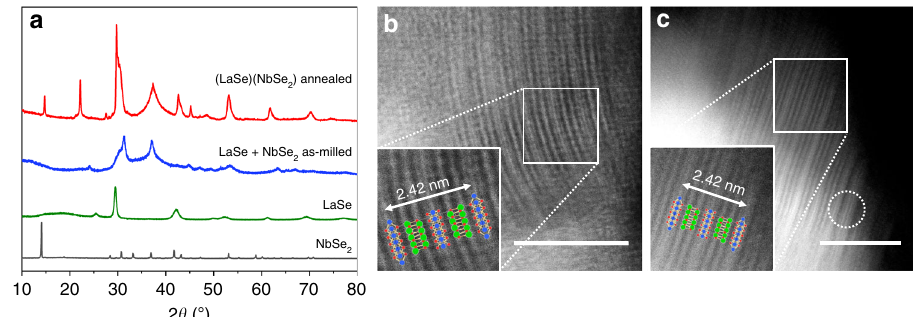
Fig. 5 Synthesis of the (LaSe)(NbSe 2 ) heterostructure. a PXRD patterns and b HAADF-STEM images of (LaSe)(NbSe 2 ) obtained by ball milling LaSe and NbSe 2 for 12 h; c the HAADF-STEM image of the annealed material. An NbSe 2 – NbSe 2 double layer is recognized in the lower right-hand corner of the image. Insets: enhanced atomic-scale views of 3D heterostructural arrangements. Scale bars,